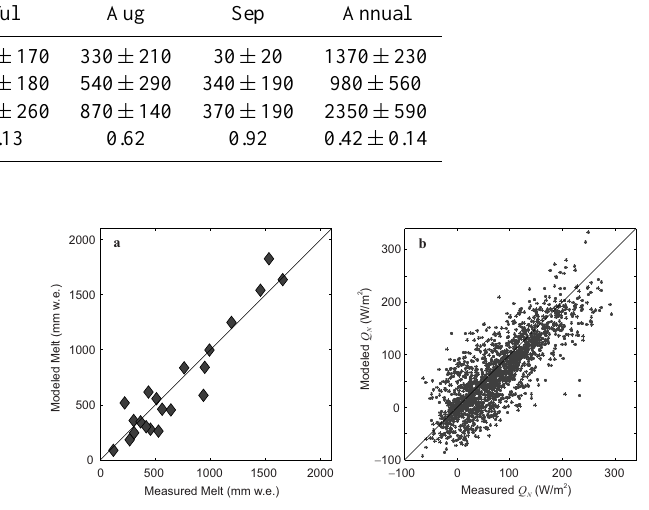
Figure 7. Measured vs. modelled (a) melt and (b) net energy bal- ance at the GAWS, 2002–2012. Melt observations are plotted for a range of time intervals for which we have direct snow pit or ablation stake data. Net energy balance values are daily for all years (May through September). One-to-one lines are plotted in each graph.